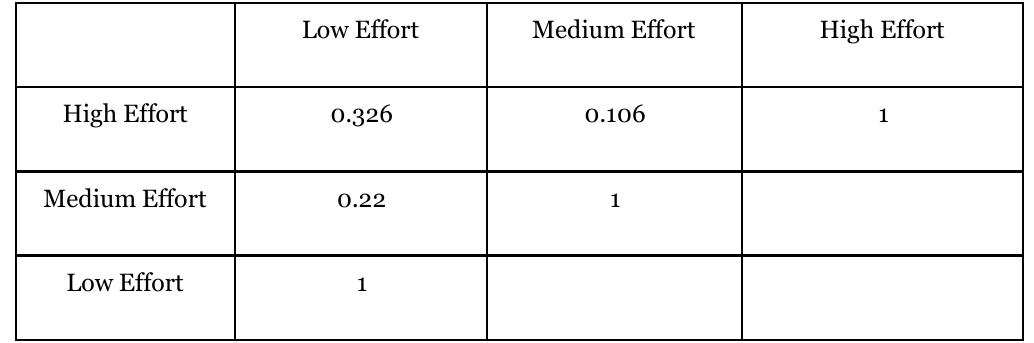
Scheffe Test for the High EL Group (n =